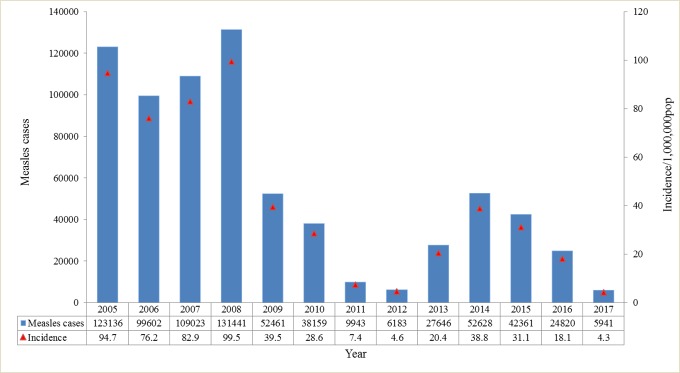
Number of measles cases and incidence from 2005 to 2017.Source: National Notifiable Disease Reporting System (NNDRS).